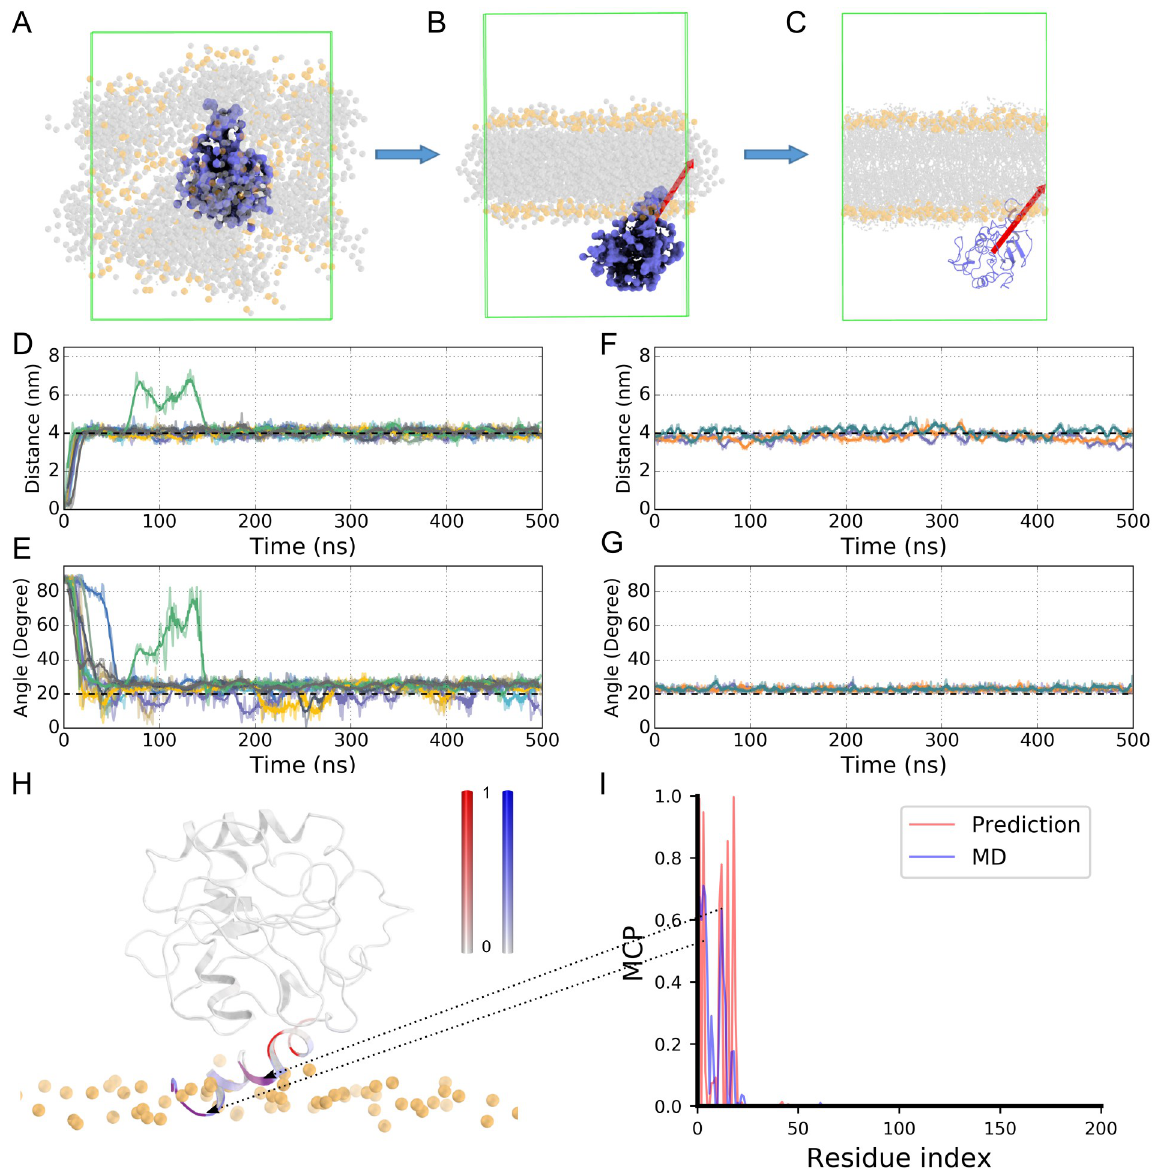
Fig 5. The Sar1 structure (1f6b) anchored on a membrane. (A) The initial and (B) final structures of the 1f6b system in the coarse-grained self- assembly MD simulations. (C) The atomistic structure of 1f6b transformed from the CG MD simulation outcome (B). The orange and grey spheres represent the lipid head groups and hydrophobic tails, respectively. The red arrow represents the first principal axis of the protein. Water molecules were filled in the whole simulation box, but are not shown here for clarity. (D) The distance between the COM of the protein and the COM of the bilayer in the nine CG simulation trajectories. (E) The orientation of 1f6b in the trajectories, represented by the angle between the first principal axis of the protein structure and the Z-axis of the simulation system. (F) Similar to (D), (G) similar to (E), but obtained from three atomistic MD simulations. (H) The orientation of 1f6b bound to the lipid bilayer obtained from MD simulations, with the membrane- interacting residues colored according to panel (I). (I) The overlaid MCP generated by our MCP predictor (red) and MD simulations (blue).